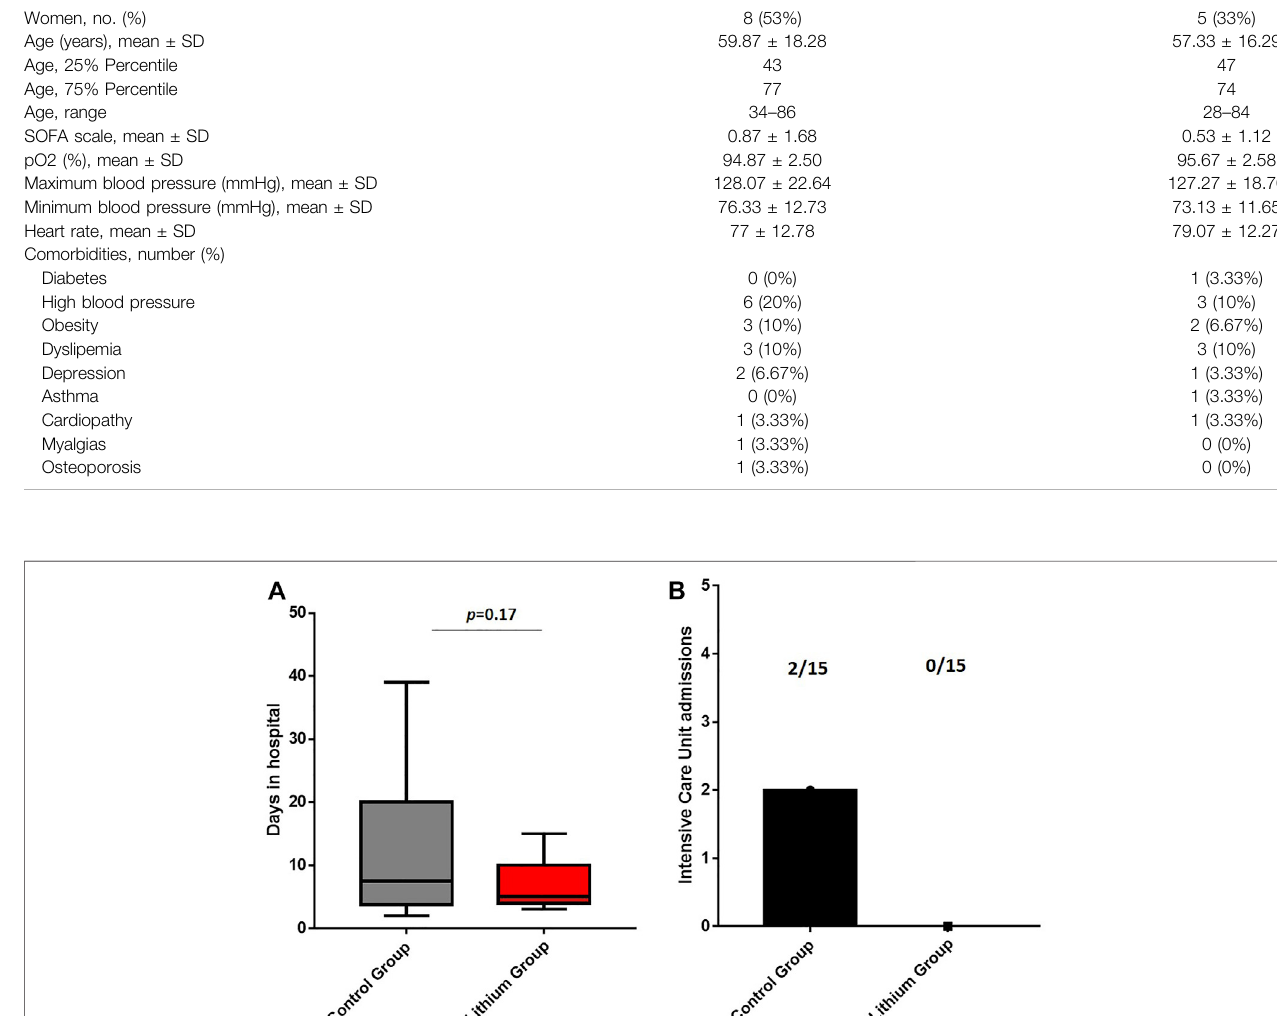
TABLE 1 | Characterization of the study group. Women, no. (%)